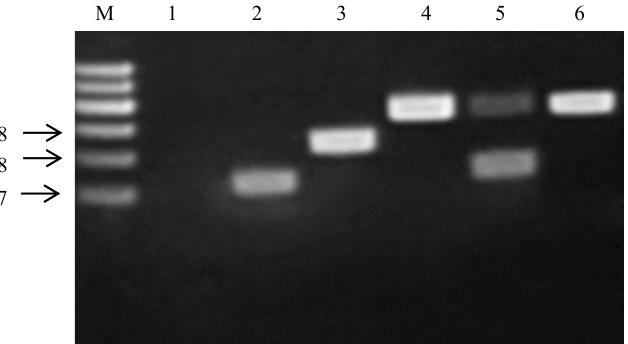
Figure 3. Amplification products obtained from the recA multiplex assay. Lane M contained a 600 bp PLUS DNA ladder (Tiangen Biotech Co, Ltd., Beijing, China). Lanes 1, 2, 3, 4 and 5 contain PCR amplication products from Lacticaseibacillus paracasei JCM 16167 T (negative control), L. paraplantarum JCM 12533 T , L. pentosus JCM 1558 T , L. plantarum JCM 1149 T and L. argentoratensis JCM 16169 T , respectively; Lane 6, PCR amplification product from